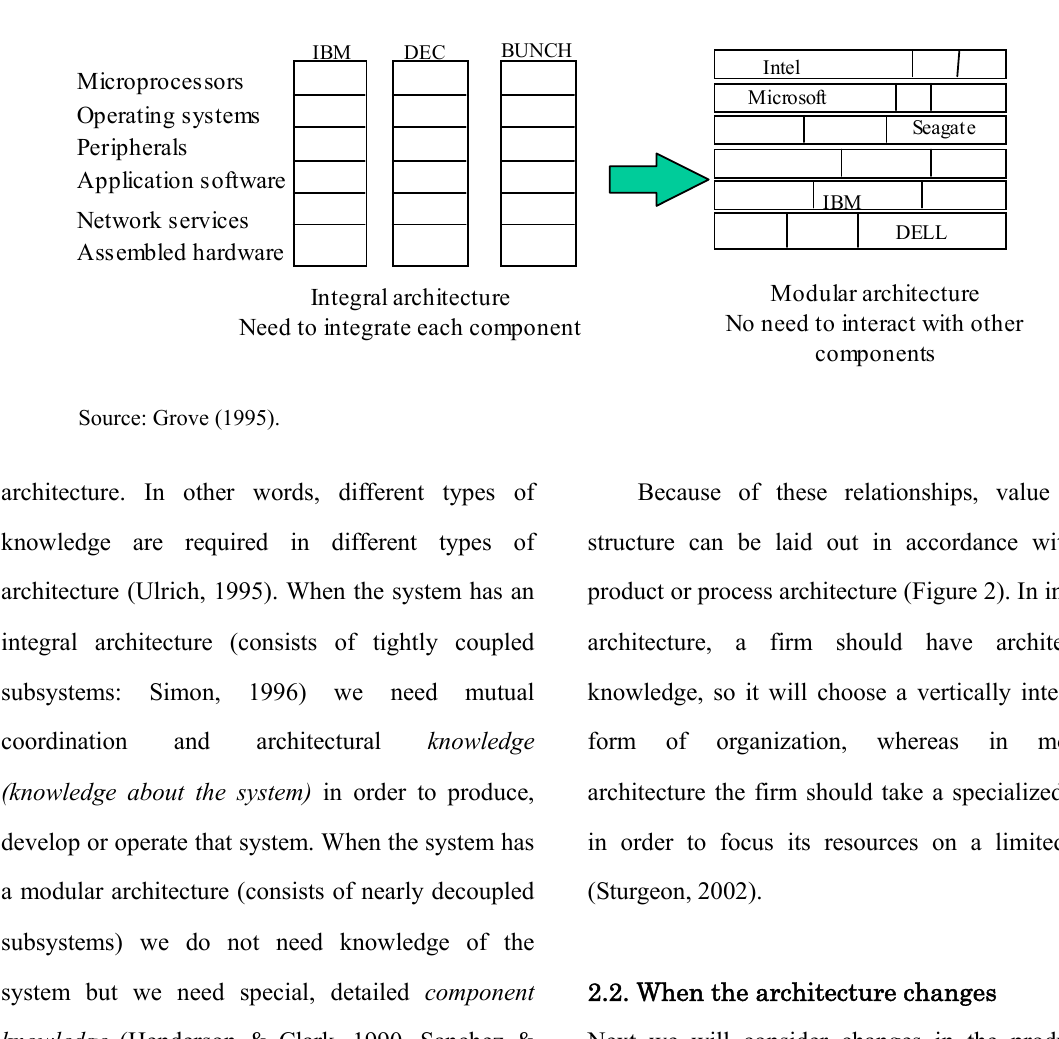
Figure 2. Change of the architecture causes that of value chain